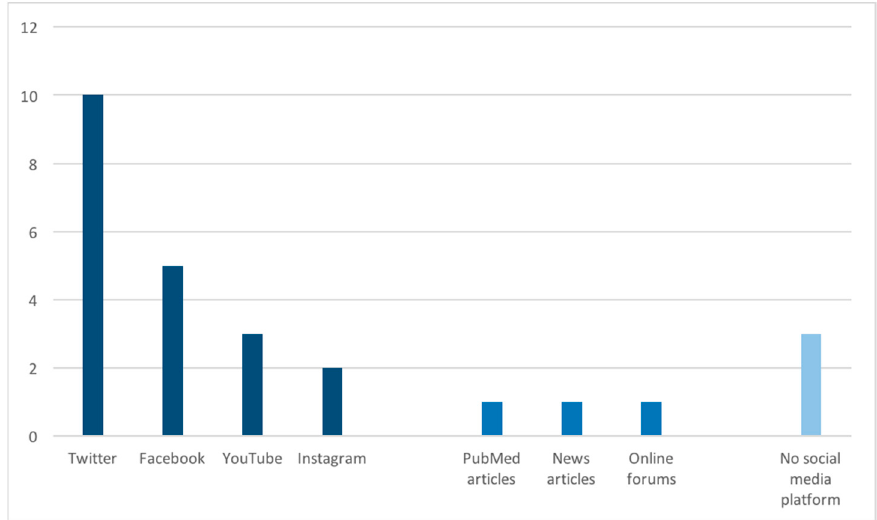
Figure 3. Domains used for data collection in selected literature: Social media domains (darkest blue), other online domains (blue) and online media not used (light blue).